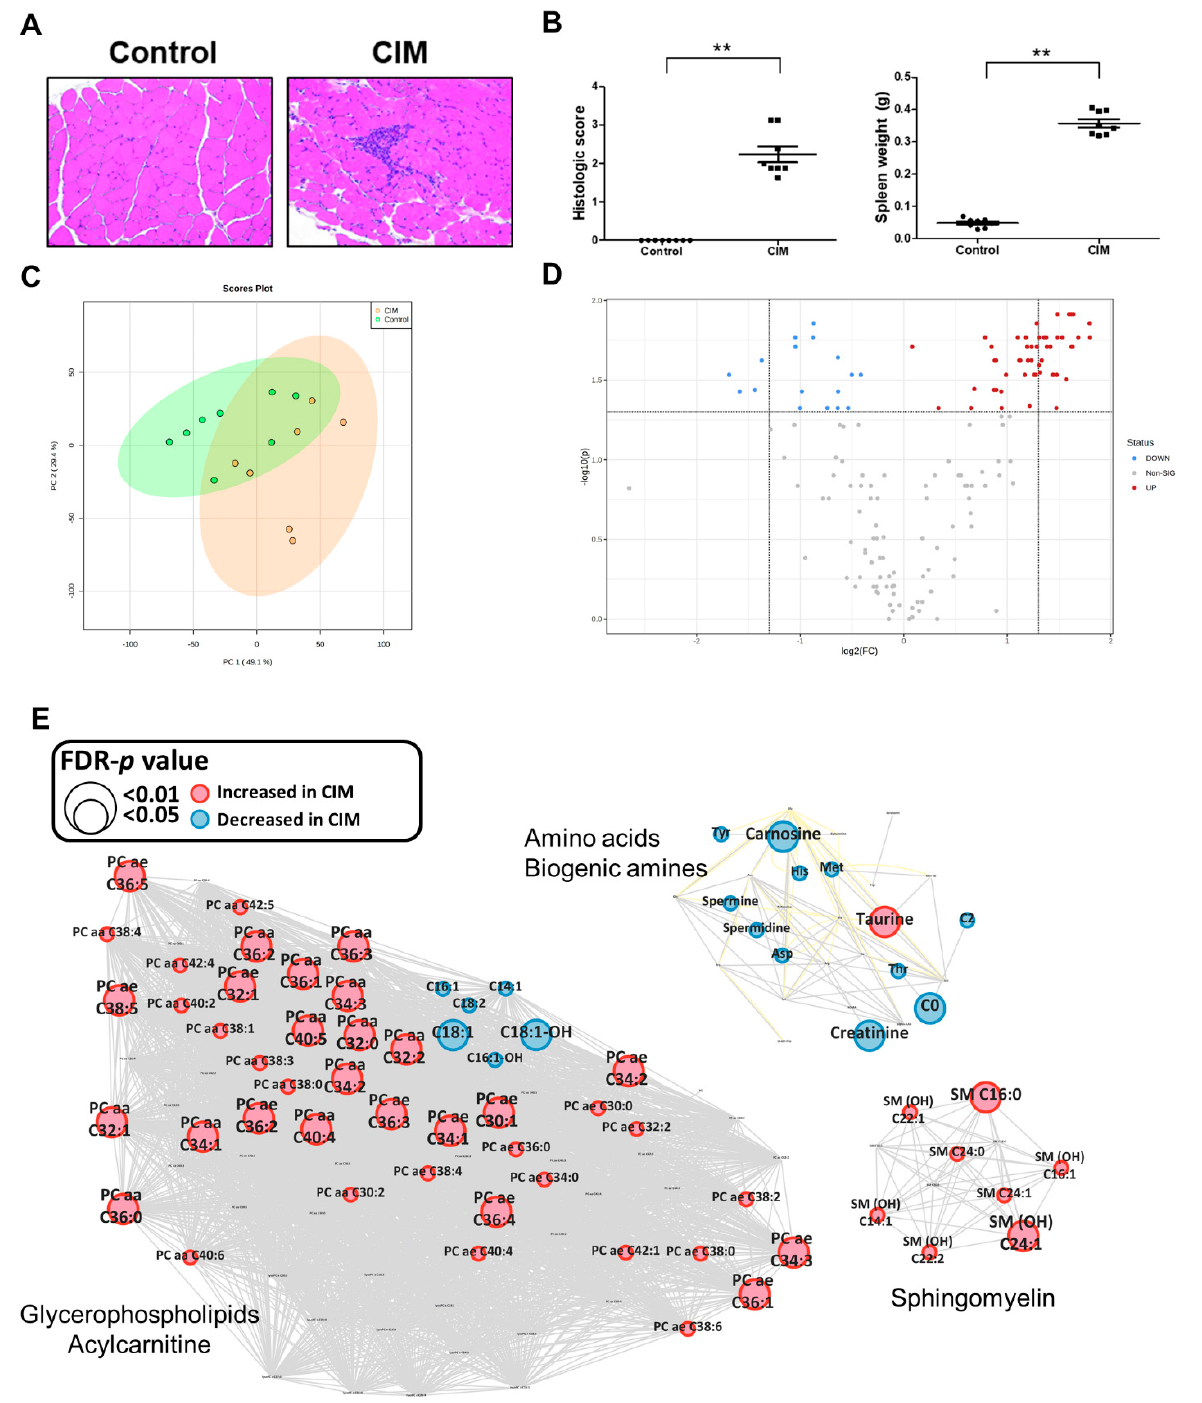
Figure 3. Effect of myositis on skeletal muscle tissue in the mouse model. ( A ) histology of control and CIM. ( B ) The histologic score of control and CIM. (** p < 0.0001) ( C ) PCA plot of control and CIM skeletal muscle tissue. ( D ) Volcano plot from t -test results of control and CIM. Red dots are upregulated metabolites, and blue dots are downregulated metabolites. ( E ) Network analysis of mouse tissue, comparing CIM and control. Border color and node color: red indicates up-regulation in CIM, and blue indicates down-regulation in CIM. Node size indicates the FDR-adjusted p -value. 3.5. Metabolic Pathway Associated with the Muscle of CIM Mice and Expression of ODC-1 and SMOX